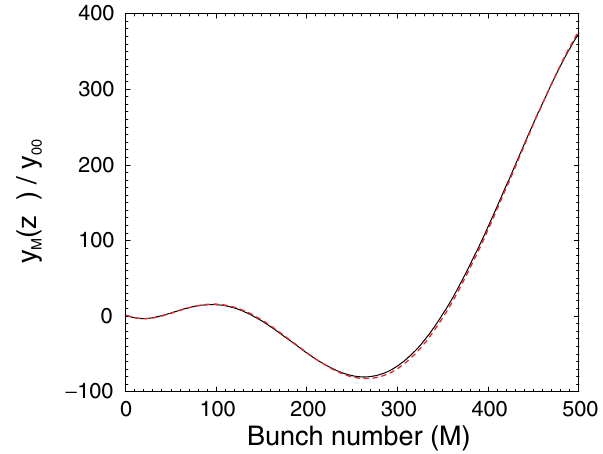
(cid:5) z (cid:6) =y for the case of injection M 00 . The solid B